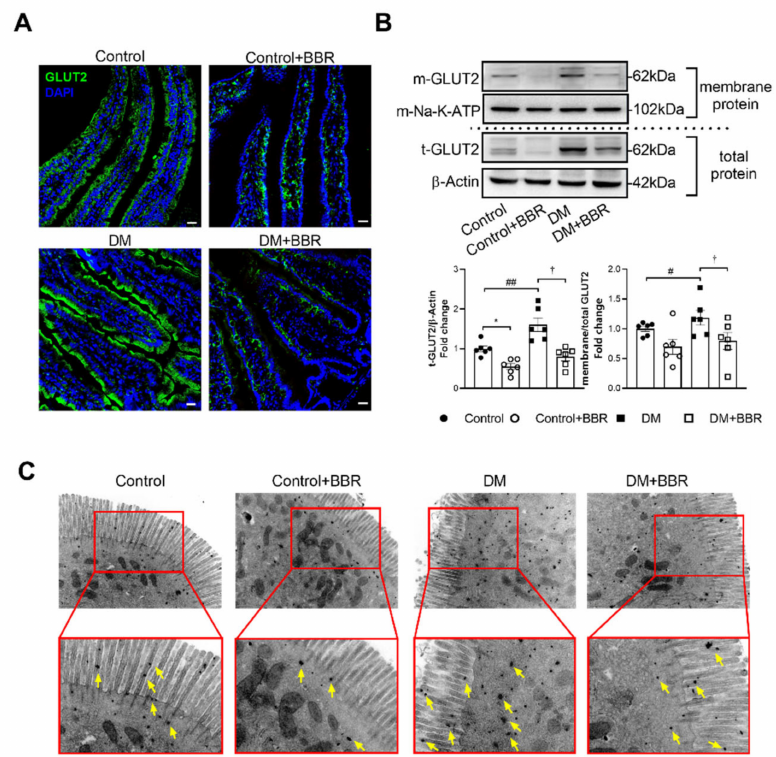
Figure 2. Berberine treatment decreased GLUT2 localization in BBM of intestinal epithelial cells in diabetic mice. ( A ) GLUT2 (green fluorescence) in BBM was decreased after berberine treatment (200 mg · kg − 1 · day − 1 , BW) for 6 weeks, bar = 20 µ m, blue fluorescence (DAPI) represented for cell nu- cleus. ( B ) Berberine treatment (200 mg · kg − 1 · day − 1 , BW) for 6 weeks decreased intestinal GLUT2 ex- pression and GLUT2 membrane localization. ( C ) Electron micrographs showed that GLUT2 posi- tive gold particles on microvillus and the BBM were decreased in berberine treated diabetic mice (DM + BBR) (200 mg · kg − 1 · day − 1 , BW for 6 weeks), bar = 0.5 µ m. Data are expressed as mean ± SEM ( n = 6). m-Na-K-ATP was used as internal reference of the membrane. Control vs. Control + BBR, * p < 0.05; Control vs. DM, # p < 0.05, ## p < 0.01; DM vs. DM + BBR, † p <